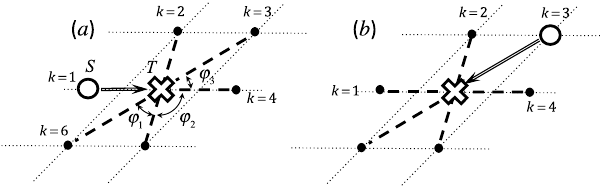
Figure 1. Examples of snapshots for the vacancy (white circles, initially at site S ) to attract a tracer (white crosses at site T ) to the vacancy’s position. The horizontal direction to the right is defined to be identical to that of the diffusion flow to be considered. The vacancy is located at one of the Z neighboring sites to site T ( Z =6 as an example in the panels) right before exchanging positions with the tracer. The vacancy site is denoted by k . The attraction angles from site k are θ 1 = π , θ 2 = π − ϕ 2 , θ 3 = ϕ 3 , θ 4 = 0 , . . . . The panel ( a ) indicates the most likely case that the vacancy pulls behind the tracer and the panel ( b ) indicates that the vacancy pulls forward the tracer after detour